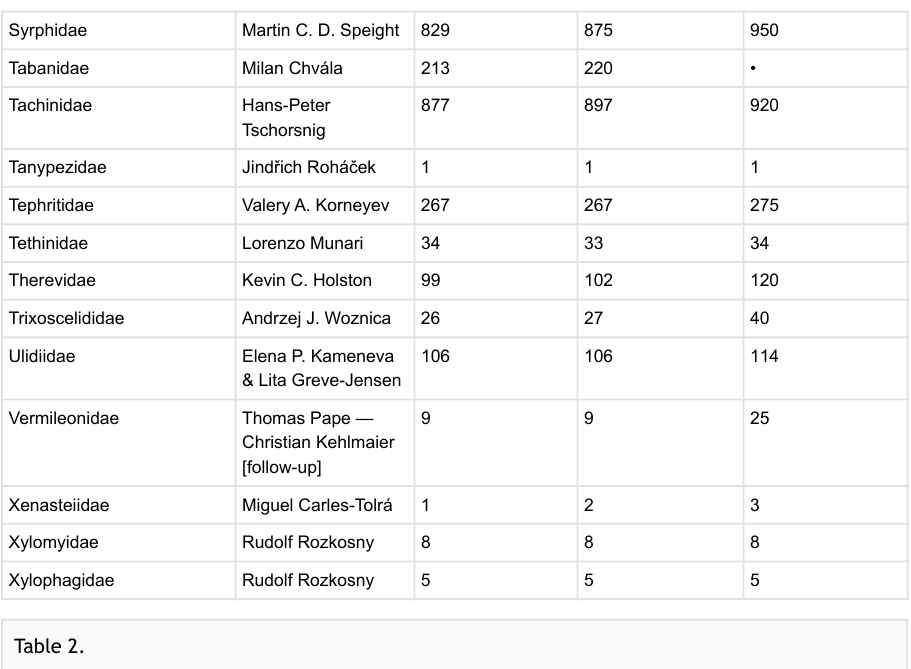
Changes in group coordinatorship and taxonomic specialists for Diptera–Brachycera, which will take effect from Version